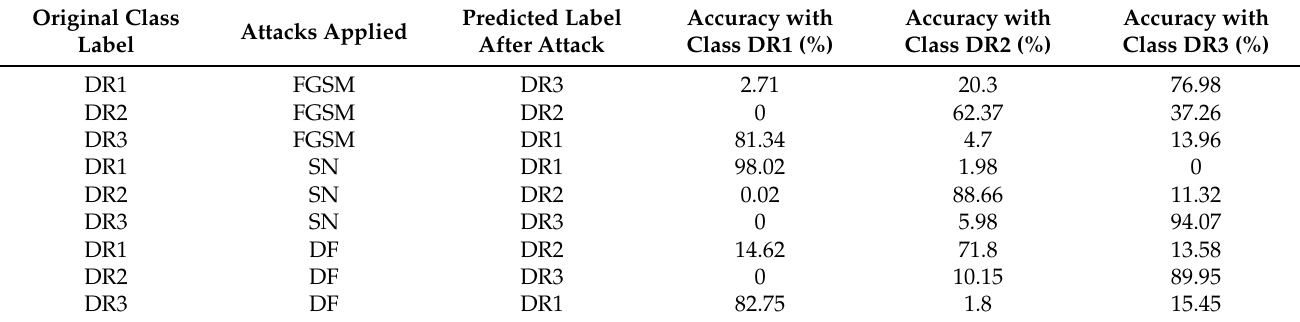
Table 4. Testing of Adversarial Training AT2 Network with Attack